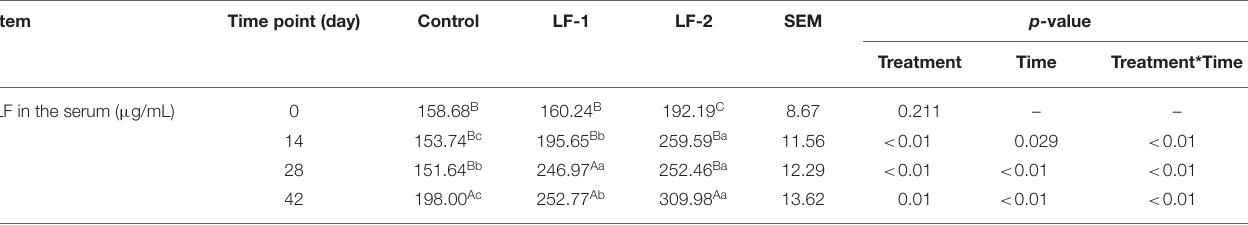
TABLE 1 | The effect of supplementation of bovine lactoferricin (BLFc) at the rate of 100 mg/kg/day (LF-1) or 200 mg/kg/day (LF-2) on the serum lactoferrin (LF) levels of dairy goats over time.